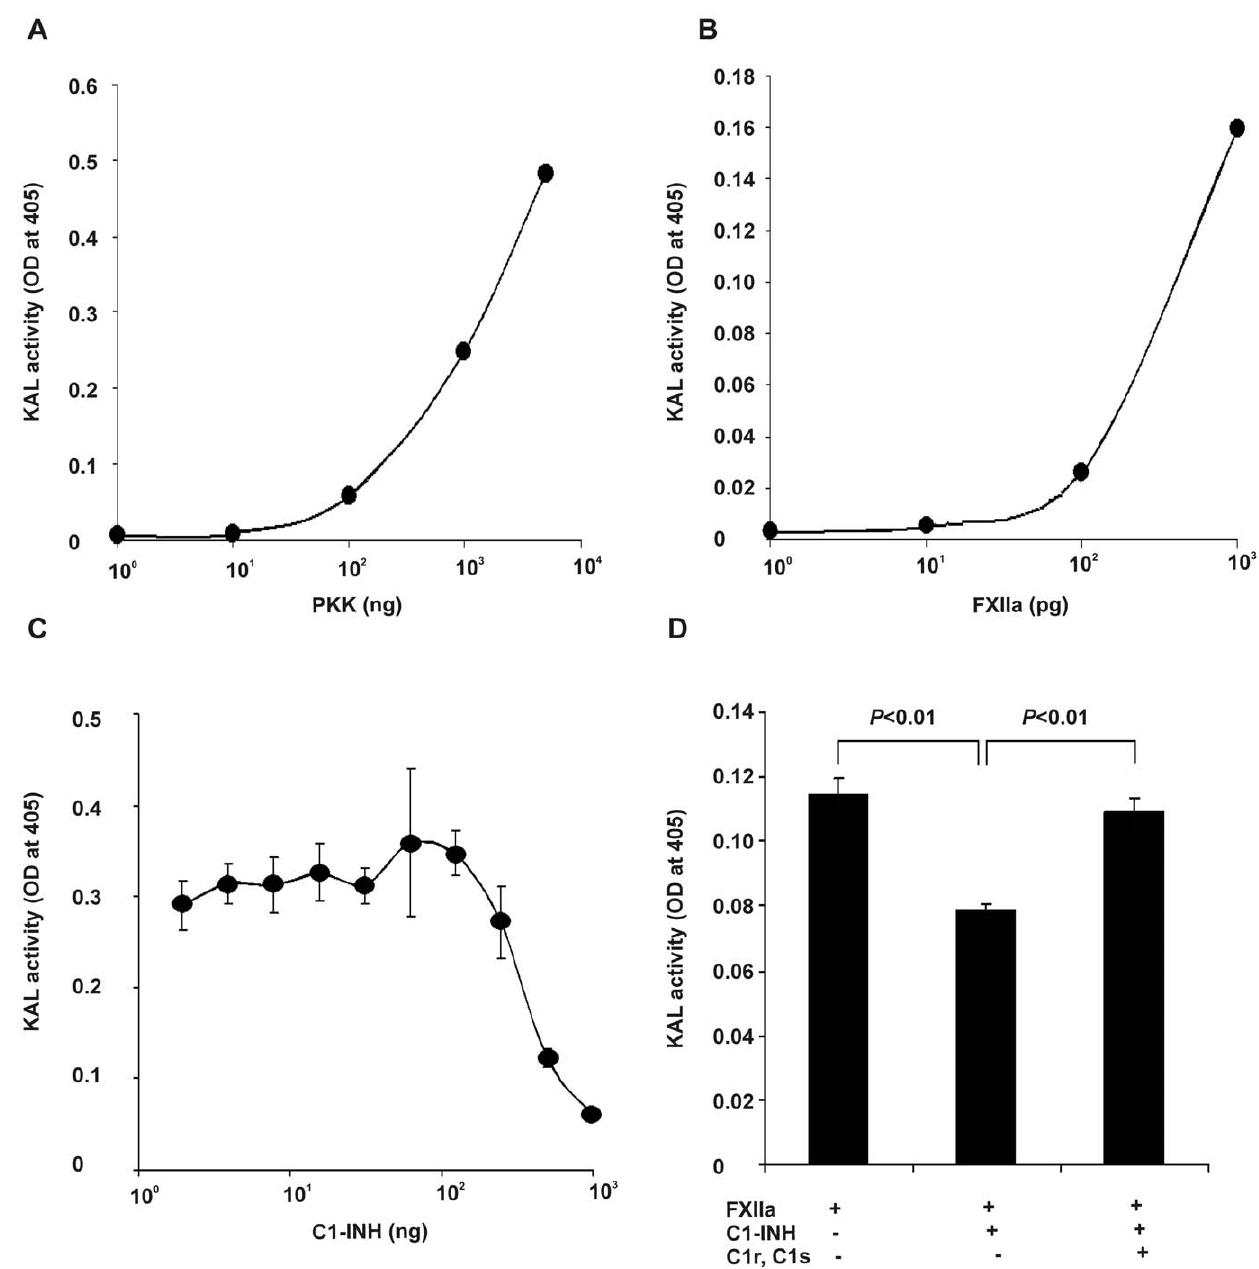
Figure 4. Complement components C1r and C1s compete with FXIIa for C1inh. Kallikrein activity of (A) different doses of prekallikrein incubated with a fixed dose (1 ng) of FXIIa; (B) a fixed dose (0.5 m g) of prekallikrein incubated with different doses of FXIIa; (C) different doses of C1inh premixed with a fixed dose (1 ng) of FXIIa before combining with prekallikrein (1 m g). (D) Kallikrein activity of 0.5 m g of prekallikrein incubated with different combinations of FXIIa, C1inh and C1r/C1s. Experiments were repeated independently at least three times. Duplicate samples were used in panels C and D.